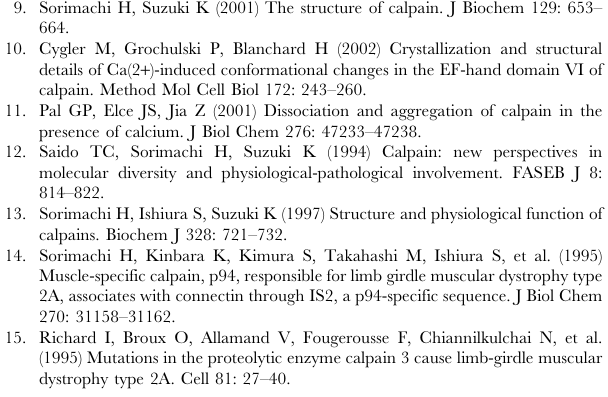
Figure S1 Comparison of the deduced amino acid sequences of calpain 1 orthologs in catfish and other organisms. Comparison of the deduced amino acid sequences of catfish calpain 1 with homologous sequences of Danio rerio (Dre, GenBank, AAF82808), Oncorhynchus mykiss (Omy, GenBank, AAT81416), and Hippoglossus hippoglossus (Hhi, GenBank, ACY78224). Identical amino acid residues are highlighted. The four catalytic subunits: I (pro-peptide), II (Cysteine catalytic site),